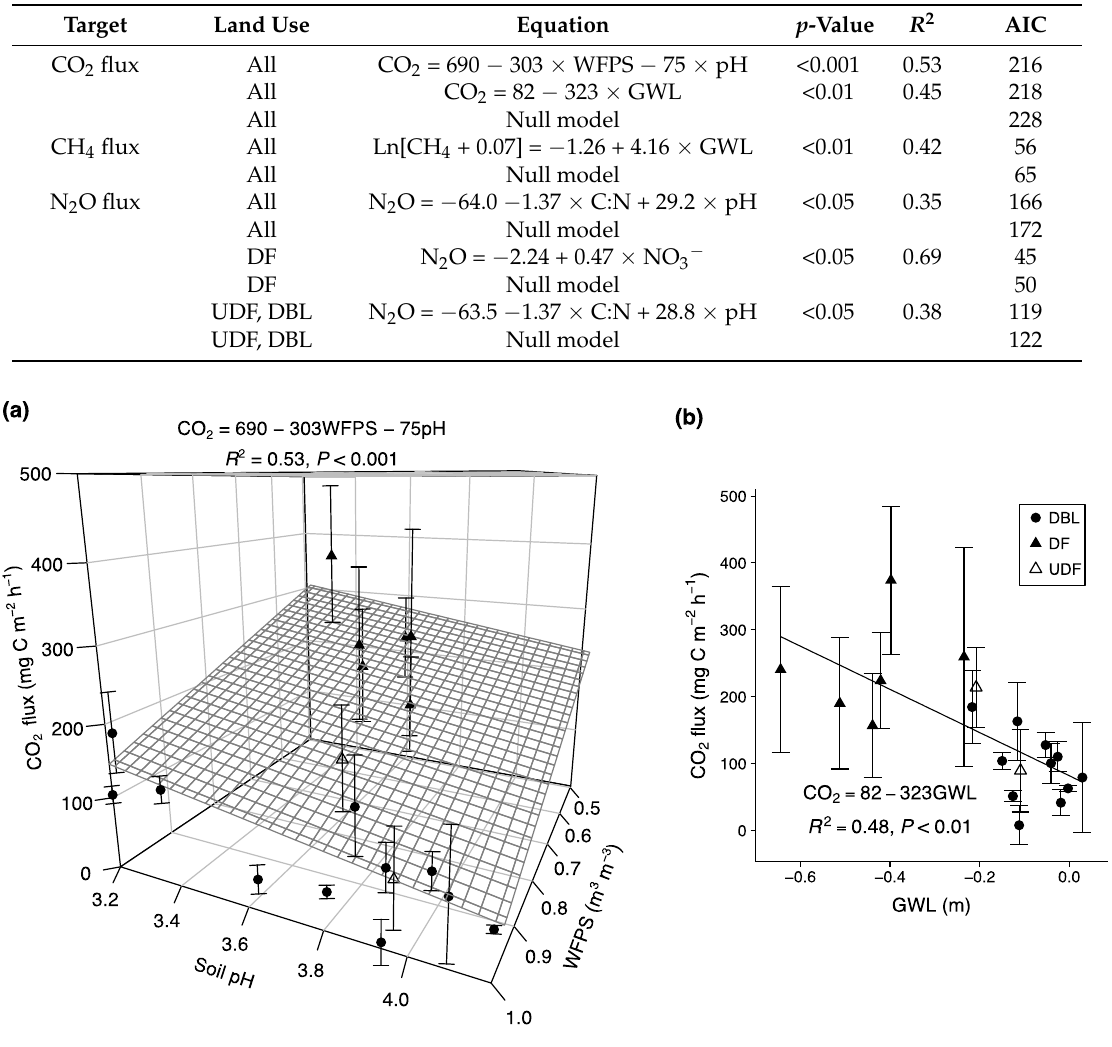
Figure 3 . Relationship between CO 2 flux and ( a ) water-filled pore space (WFPS) and soil pH, and ( b ) groundwater level (GWL) in DBL (drained burned land), DF (drained forest), and UDF (undrained forest). Error bars show ±1 SD. Meshed surface and line show the result of regression (Table 3).